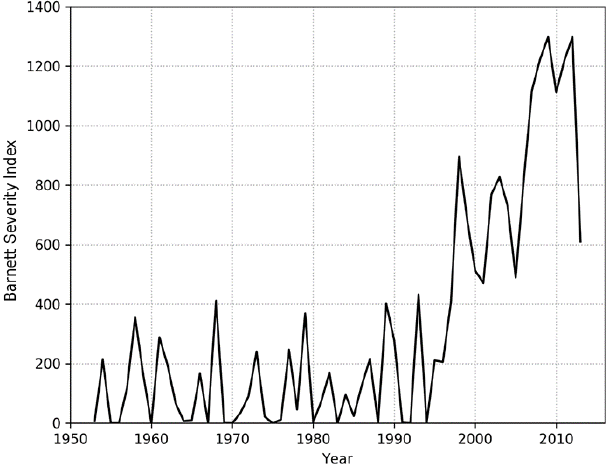
Figure 2. Time series of the Barnett Severity Index (BSI), 1953– 2013.